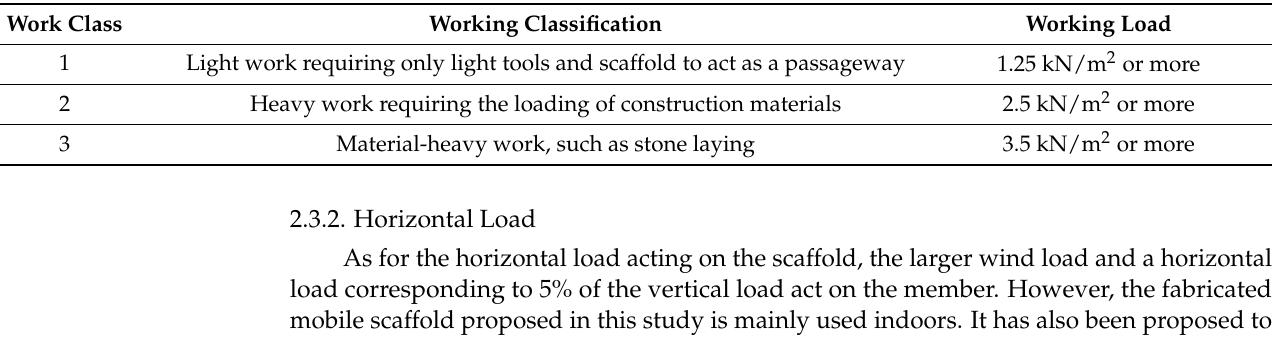
Table 8. Working load class according to the working classification of scaffold.